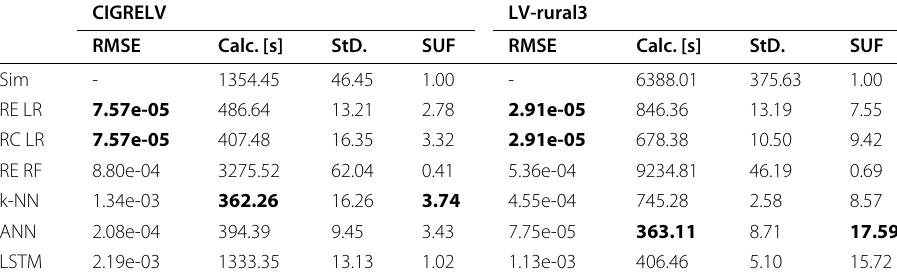
Table 2 Overview of RMSE, mean calculation time (Calc. [s]), its standard deviation (StD.), and the models’ speed-up factor (SUF) relative to the simulation model (Sim). Bold values mark the best of the respective column CIGRELV LV-rural3 RMSE Calc. [s] StD. SUF RMSE Calc. [s] StD. SUF Sim - 1354.45 46.45 RE LR RC LR 7.57e-05 407.48 RE RF 8.80e-04 3275.52 k-NN 1.34e-03 ANN 2.08e-04 LSTM 2.19e-03